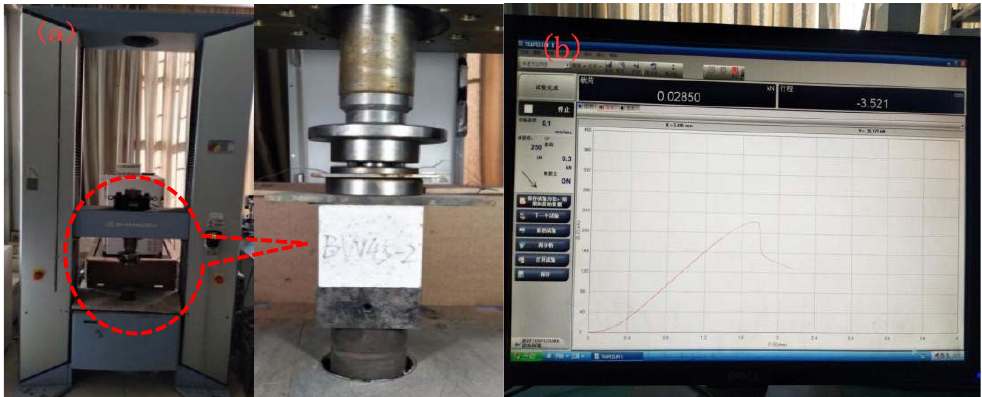
Figure 3. Process of determining compressive strength: ( a ) AGX-250 electronic universal testing machine; ( b ) test interface.